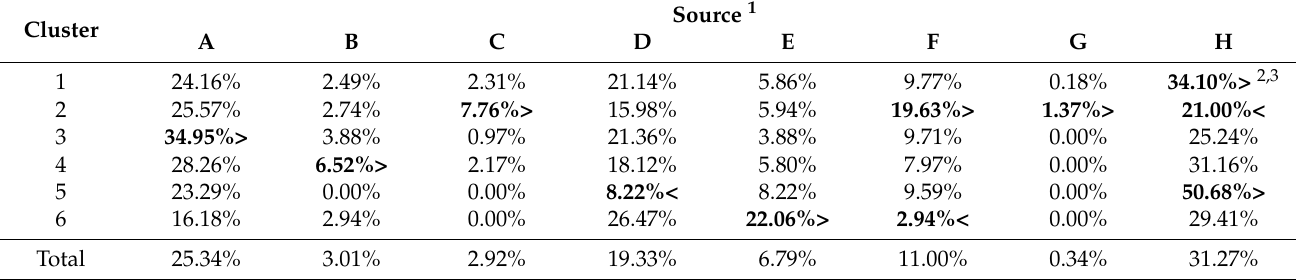
Table 12. Distribution clusters by source of reporting of sequences from clinical